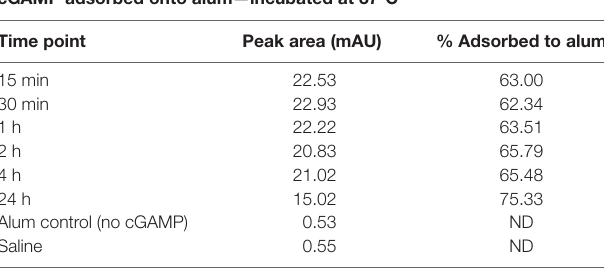
RP-HPLC, reverse-phase high performance liquid chromatography.